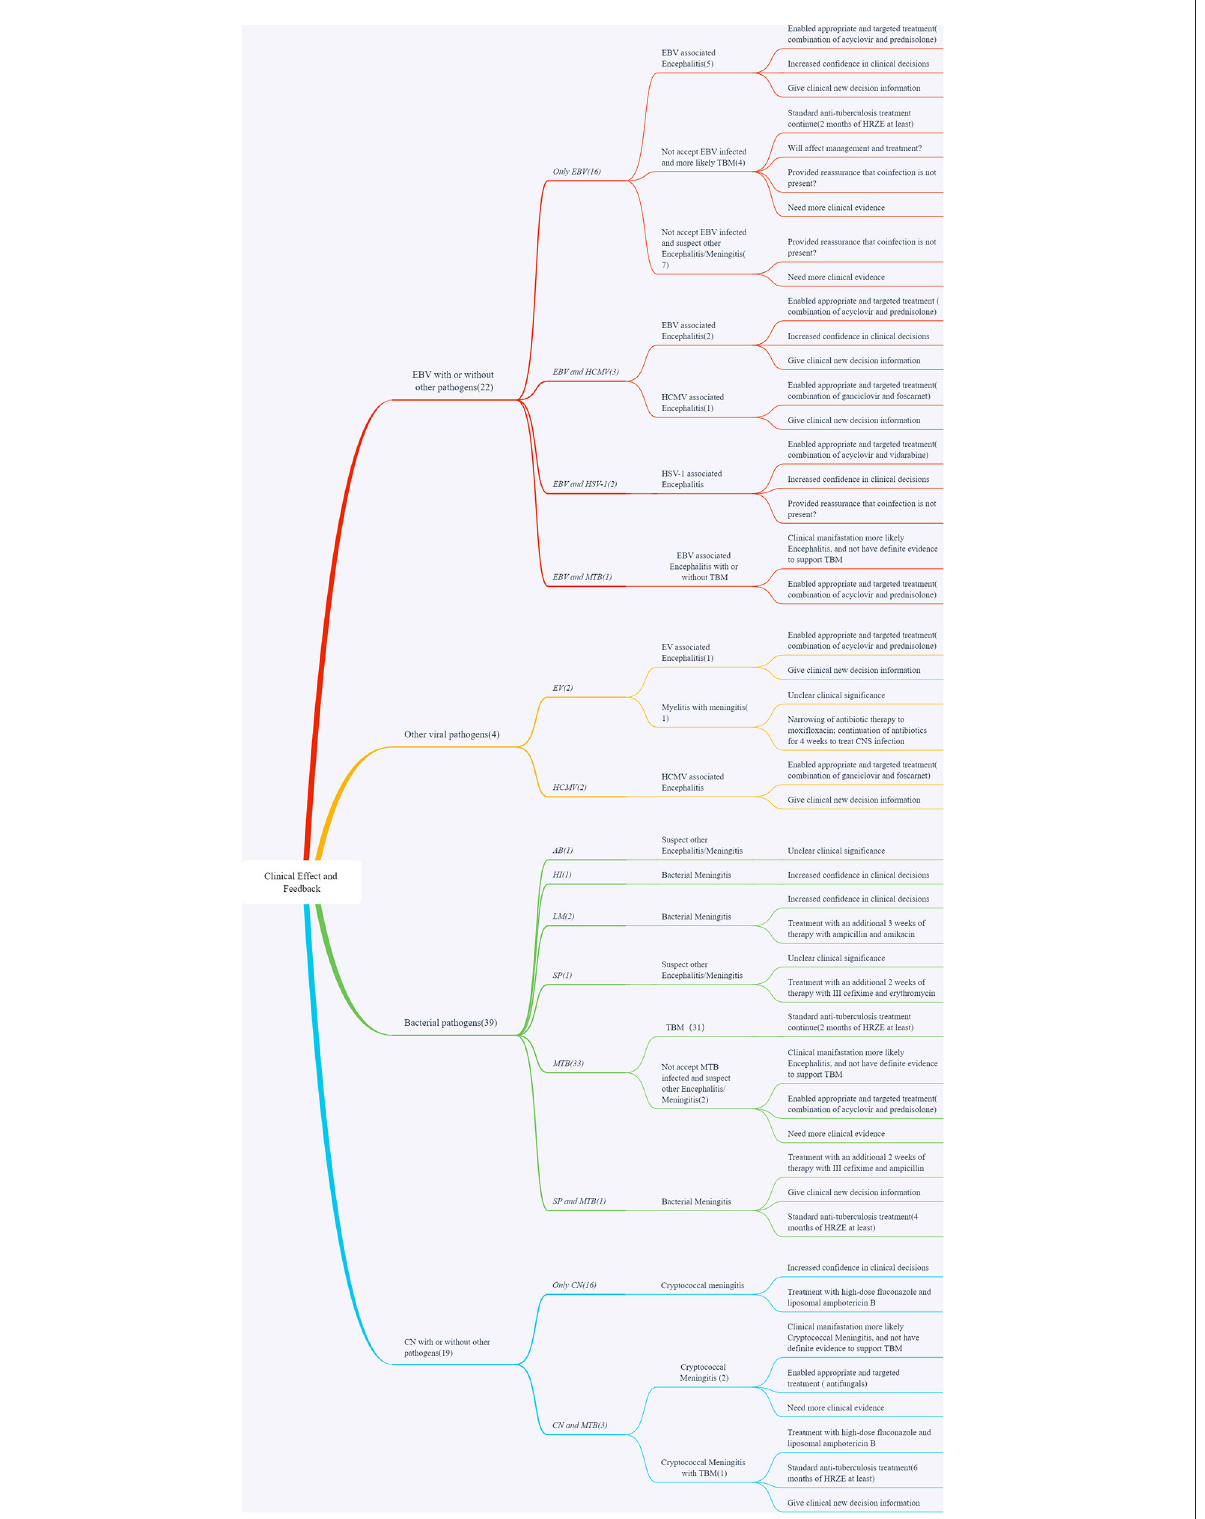
FIGURE4 Clinical effect and feedback. ME, Infectious meningitis and encephalitis; MME-18, Multiplex PCR detection for 18 pathogens of ME; MTB, Mycobacterium tuberculosis ; HI, Haemophilus influenzae ; MP, Mycoplasma pneumoniae ; SP, Streptococcus pneumoniae ; AB, Acinetobacter baumannii ; LM, Listeria monocytogenes ; EV, Enterovirus; HSV-1, Herpes simplex virus-1; EBV, Epstein-Barr virus; CMV, Cytomegalovirus; CN, Cryptococcus